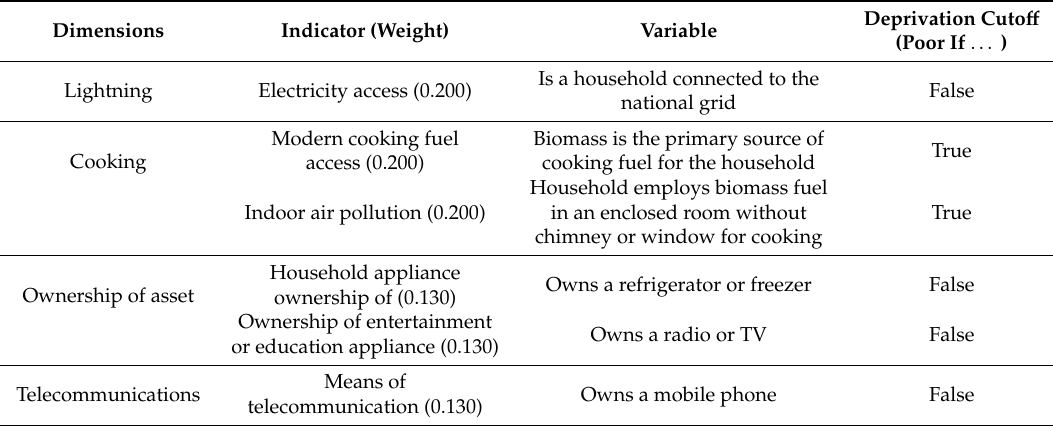
Table 1. Dimension and indicators of the Multidimensional Energy Poverty Index